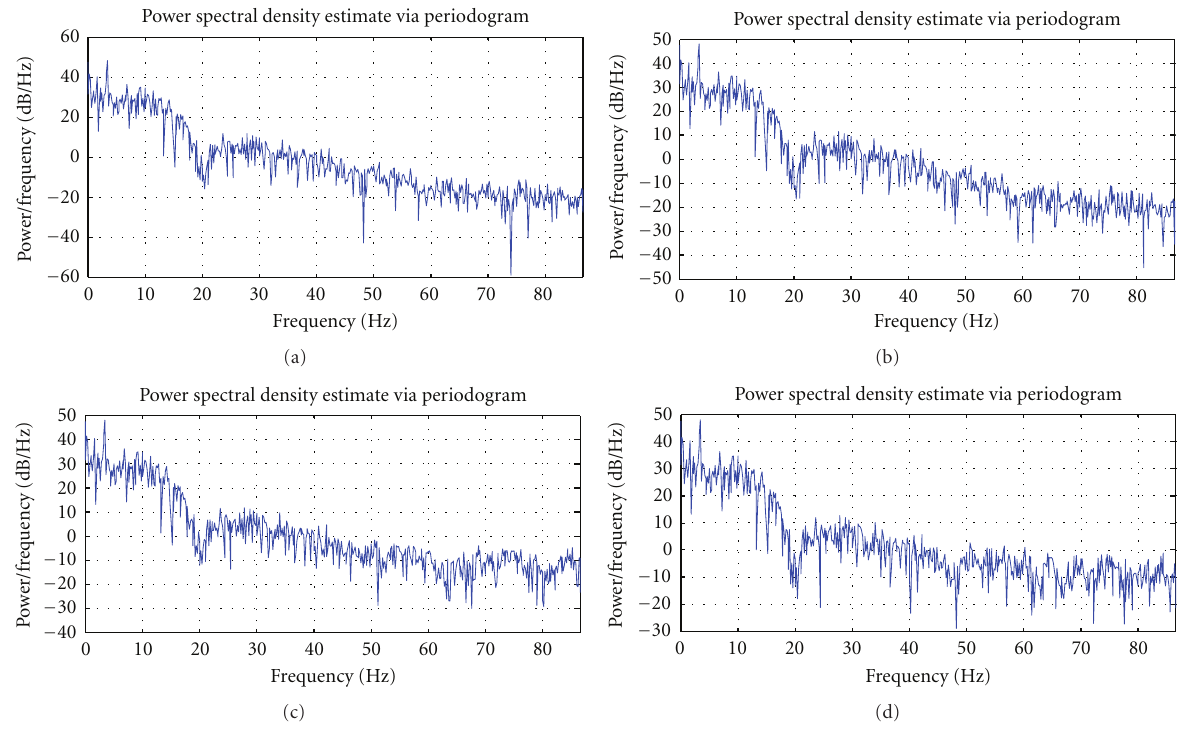
Figure 11: Power spectra of EEG dataset2: (i) original signal, (ii) reconstructed signal at T = 7 at Q1, (iii) reconstructed signal at T = 5 at Q2, and (iv) reconstructed signal at T = 5 at Q3.